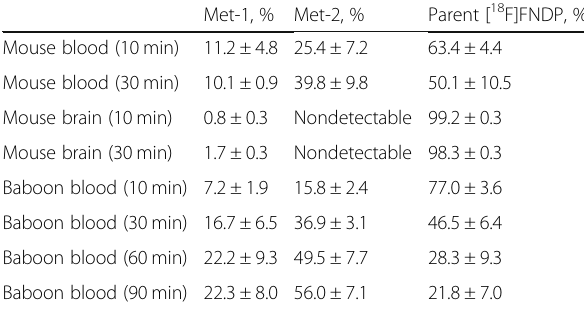
Table 3 HPLC analysis of radiolabeled metabolites of [ 18 F]FNDP in mouse blood and brain and baboon blood Met-1, % Met-2, %